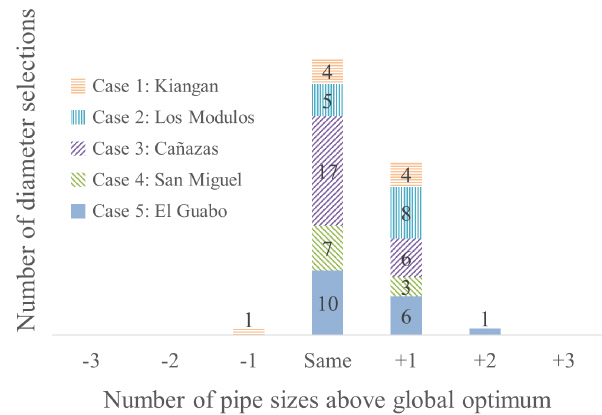
Figure 6. Diameter sizes from calculus-based (CB-Disc) solutions compared with global optimum solutions (from backtracking, BT). A global optimum for case 6, Los Mangos, is not included since BT did not complete after 7 days of